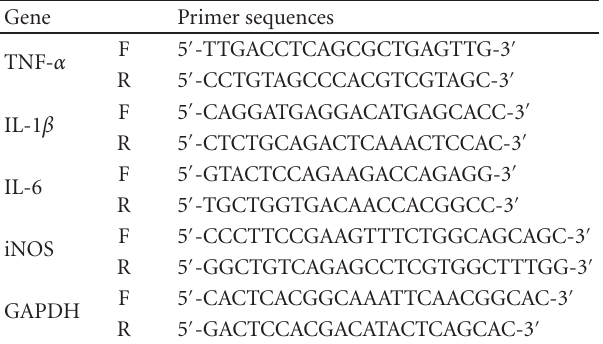
Table 1: Primers used for RT-PCR analysis (F: forward, R: